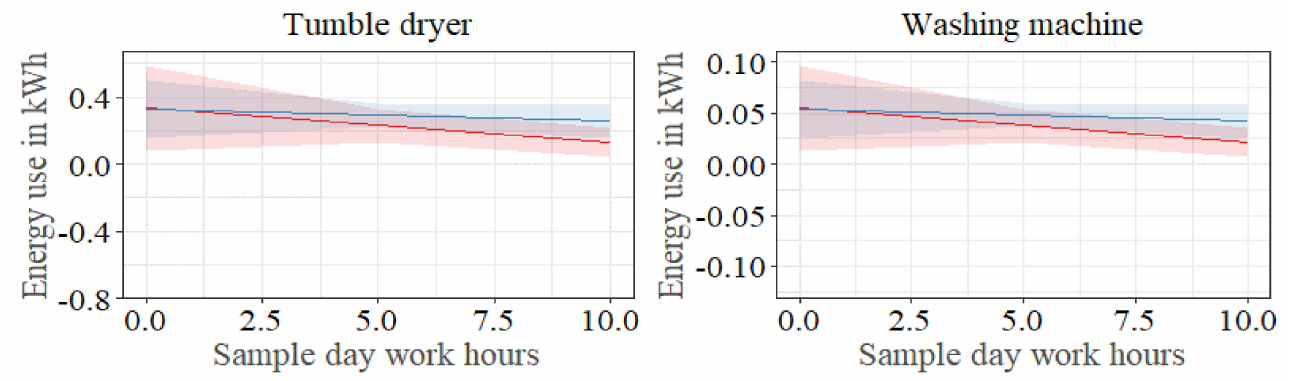
Figure 7. Significant linear regression lines of regular work patterns. (Blue line part-time and red line